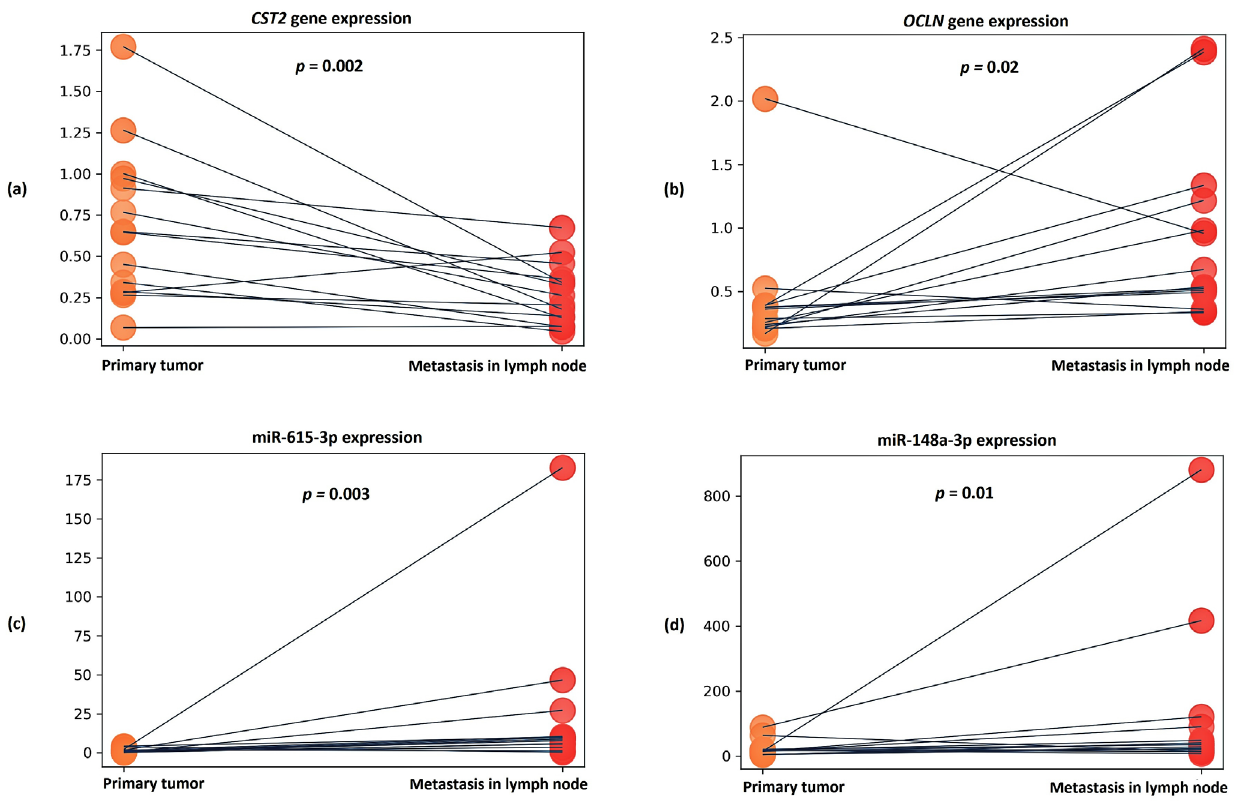
Figure 5. Dot plots showing relative expression results for ( a ) CST2 gene, ( b ) OCLN gene, ( c ) miR- 615-3p, and ( d ) miR-148a-3p between groups of primary tumors and lymph node metastases. The y axis represents the 2 −ΔCT values. The gray line indicates the direction of relative expression of the transcript between groups for each patient.